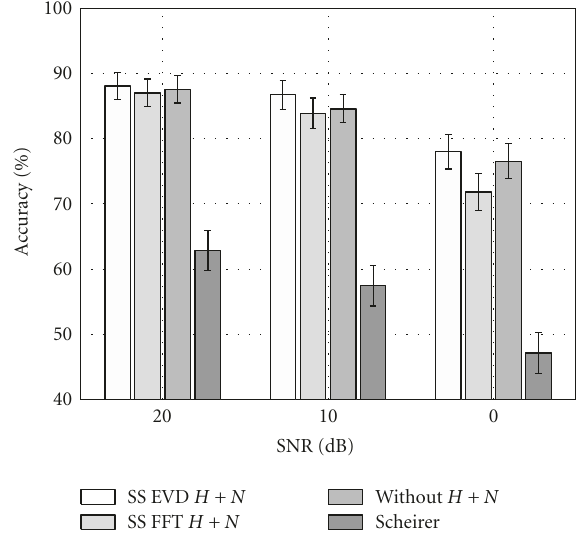
Figure 15: Robustness to signal degradation. The EVD H + N algo- rithm displays the highest strength to signal